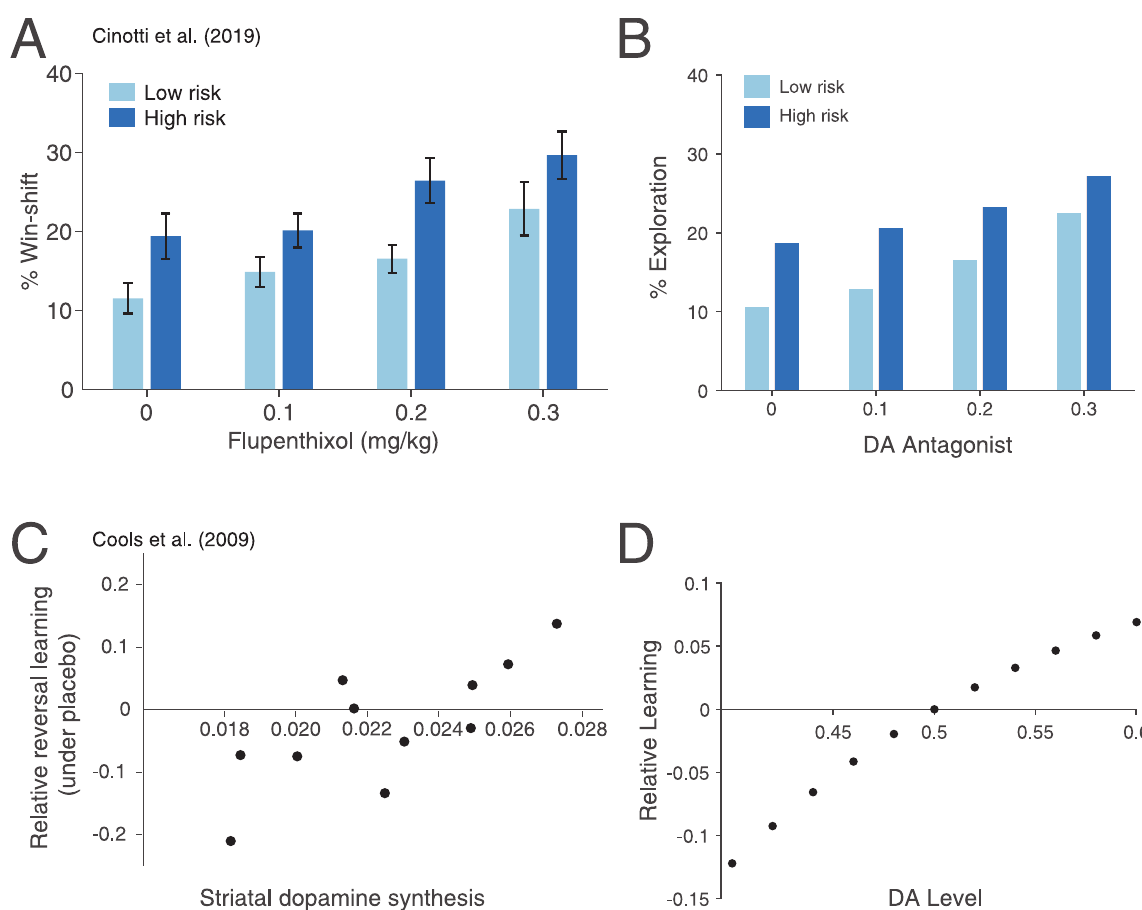
Fig 4. Rational inattention and reinforcement learning. (A) Using a non-stationary three-armed bandit task, Cinotti et al. [30] have shown that the DA antagonist flupenthixol promotes exploration (win-shift behavior). The task furthermore included two different risk levels: In low- risk conditions, one lever was rewarded with probability 7/8, and the other two with probability 1/16 each; in high-risk conditions, one lever was rewarded with probability 5/8, and the other two with probability 3/16 each. The effect of DA was evident for both conditions, and win-shift behavior was more pronounced in high-risk conditions across DA levels. Figure adapted from [30]. (B) Our model recapitulates these results: As DA decreases, likelihood precision decreases, which in turn reduces the difference in posterior means, and encourages exploration. The effect of risk on exploration follows from the reduced differences in likelihood means (and, by extension, posterior means) in high-risk compared to low-risk conditions. (C) Cools et al. [23] have shown that human subjects with high DA synthesis capacity learn better from unexpected rewards than from unexpected omissions of reward, whereas subjects with low DA synthesis capacity learn better from unexpected omissions than unexpected rewards. Relative accuracy is the accuracy following unexpected rewards minus the accuracy following unexpected punishments, taken to indicate the extent of learning from positive feedback compared to negative feedback. Figure adapted from [23]. (D) Our model recapitulates this result: High DA shifts the agent’s beliefs toward expecting positive feedback. Thus the speed of convergence for learning high rewards increases. Similarly, the speed of convergence for learning low rewards increases under low DA. The asymmetry in relative learning is due to an asymmetry in precision: Under high DA, likelihood precision is high, so the prior has a weaker effect than under low DA. For (B, D), see Methods for simulation